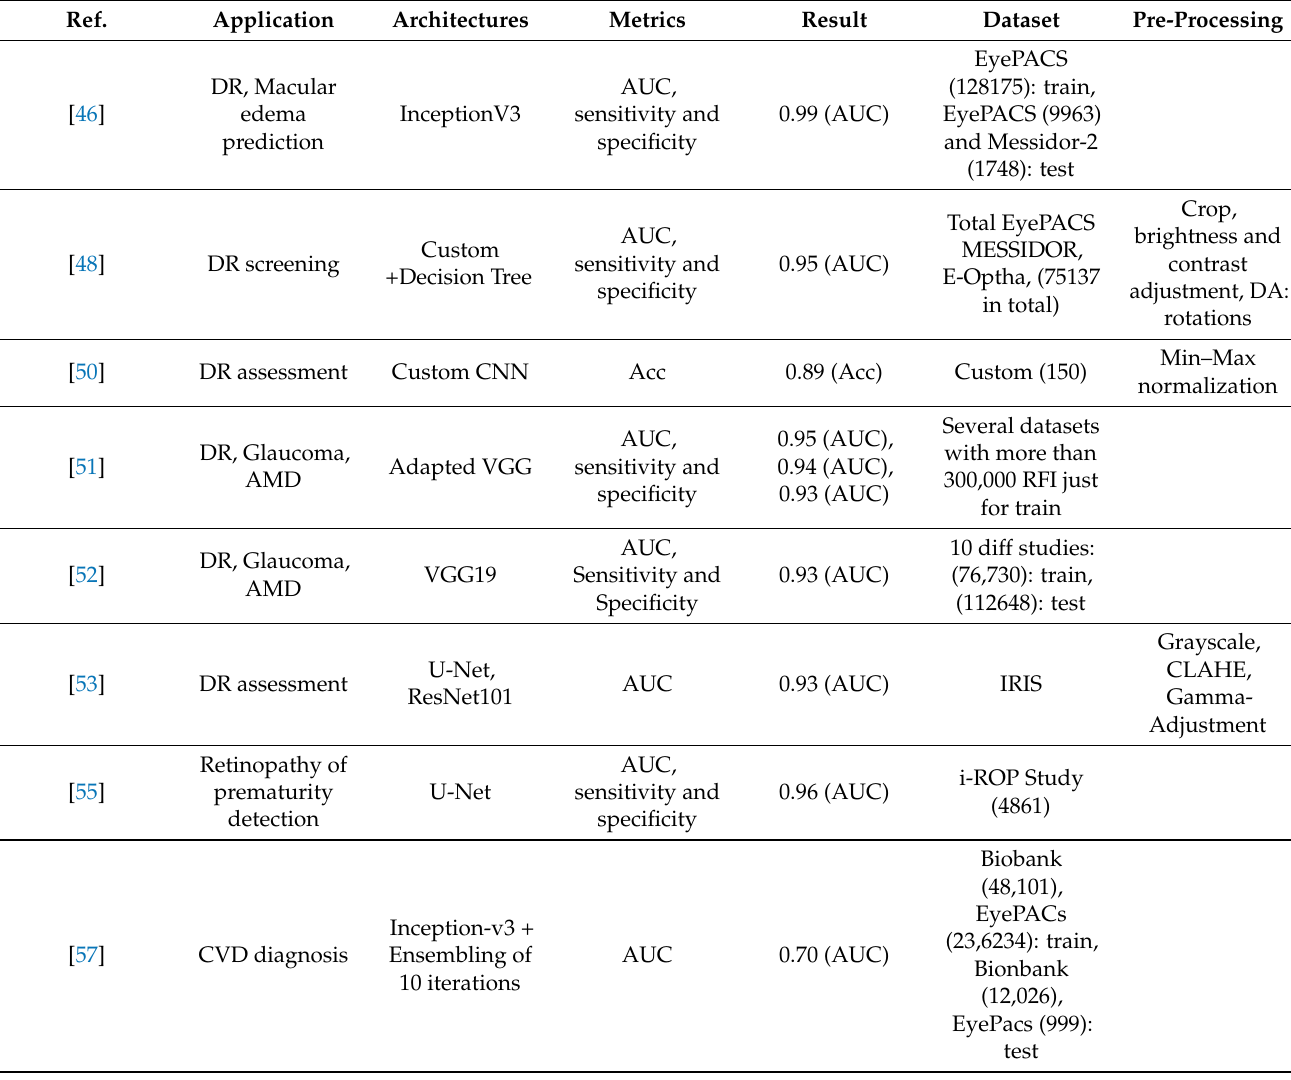
Table 5. Automated prediction of cardiovascular risk factors